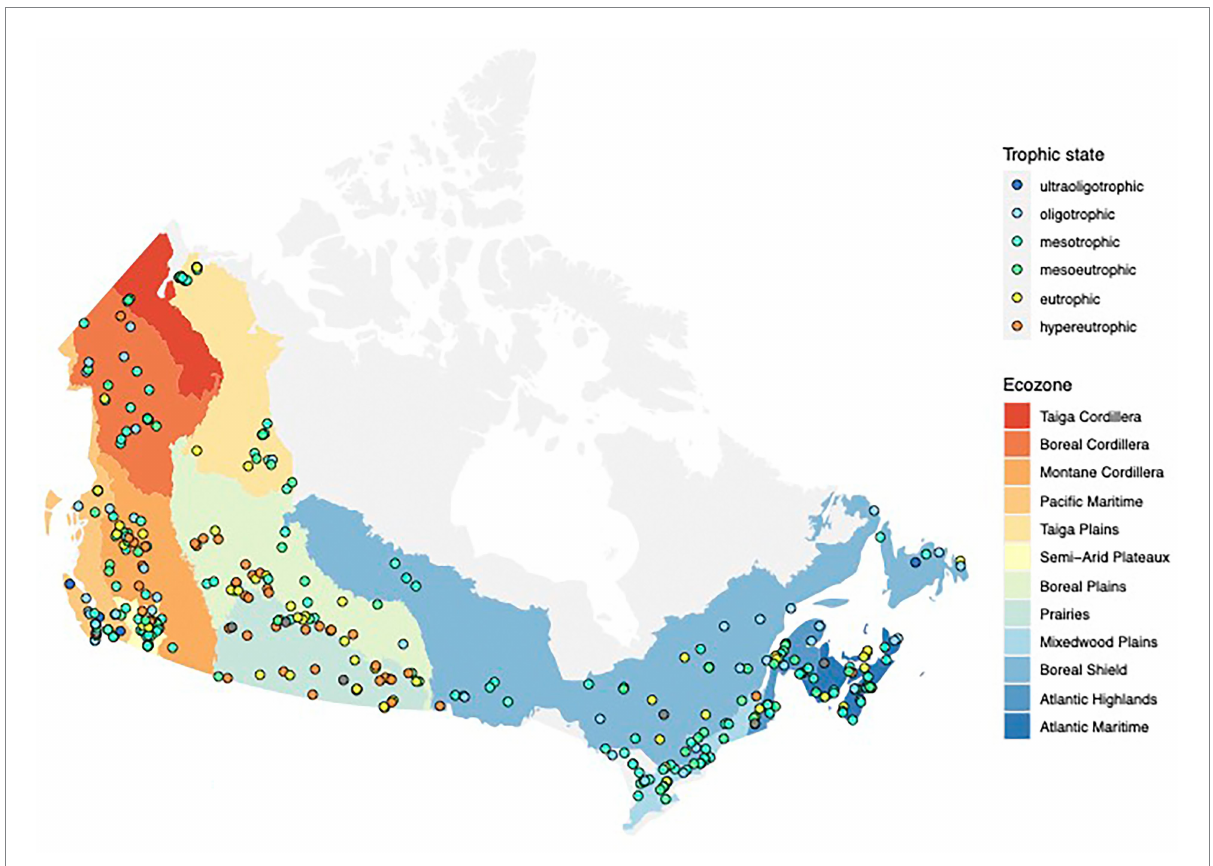
FIGURE 1 Map showing the locations of the 349 lakes in this study. The trophic state of each lake at the time of the sampling is indicated by the color of the